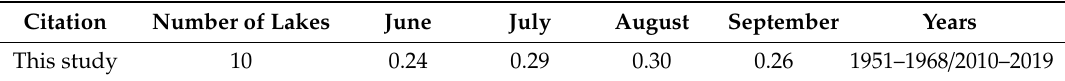
Table 4. Lake surface (in defined water layer 0–3 m) temperature trends of northern Poland lakes. Presented trends are average (sometimes range) in ◦ C decade − 1